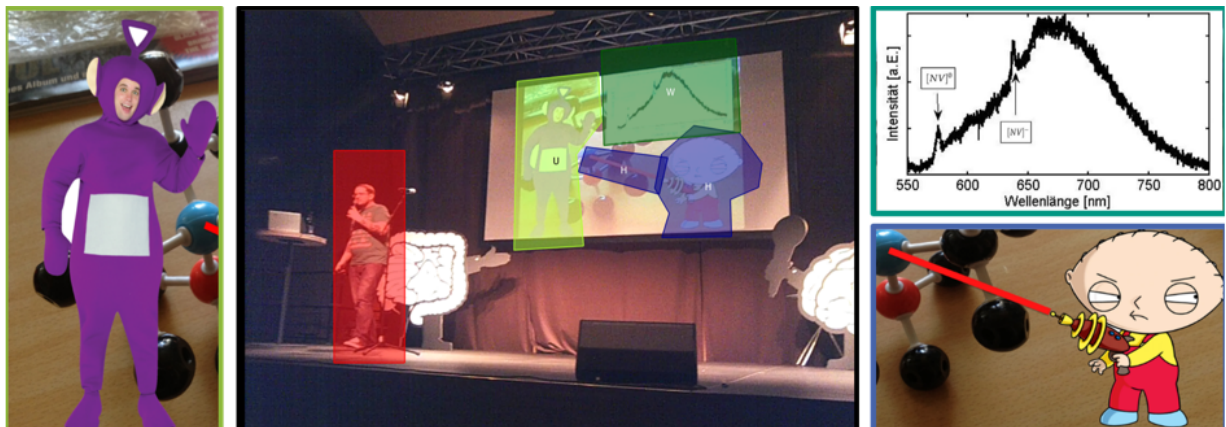
Figure 3. AOIs in the talk by Reinhard Remfort. Notes: Examples of material assigned to the categories “science” (dark green, top right), “hybrid” (dark blue, bottom right), and “entertainment” (light green, left). The presenter is marked in red.